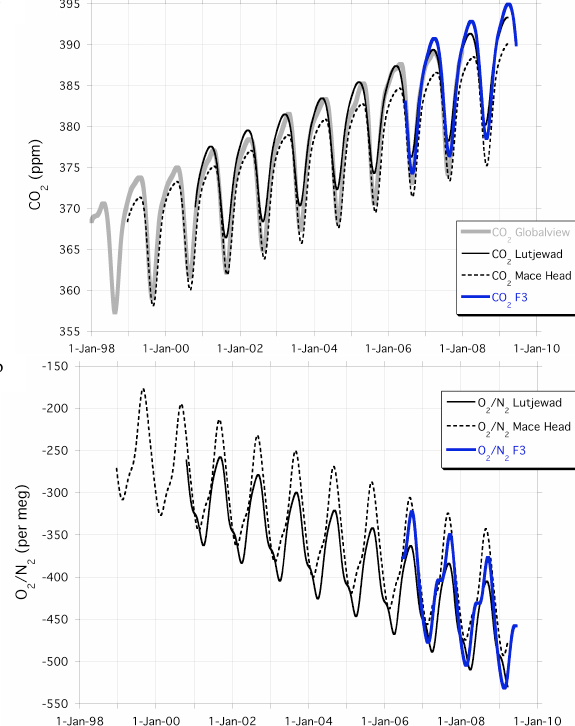
Fig. 4. Trend fits of CO 2 (a) and O 2 (b) at Lutjewad (solid black line), Mace Head (dashed black line) and F3 (solid blue line) during 1998–2009, based on flask measurements (and continuous measurements for F3). The fits are a linear combination of a three harmonic function and a linear trend through the data points (in Fig. 3). The CO 2 trends of the three measurement locations are shown in comparison to the CO 2 background reference concentration according to GLOBALVIEW-CO 2 (2008) (solid grey line) at latitude 53 ◦ N. The increasing gradients between Mace Head and Lutjewad are visible for both CO 2 and δ O 2 /N 2 .